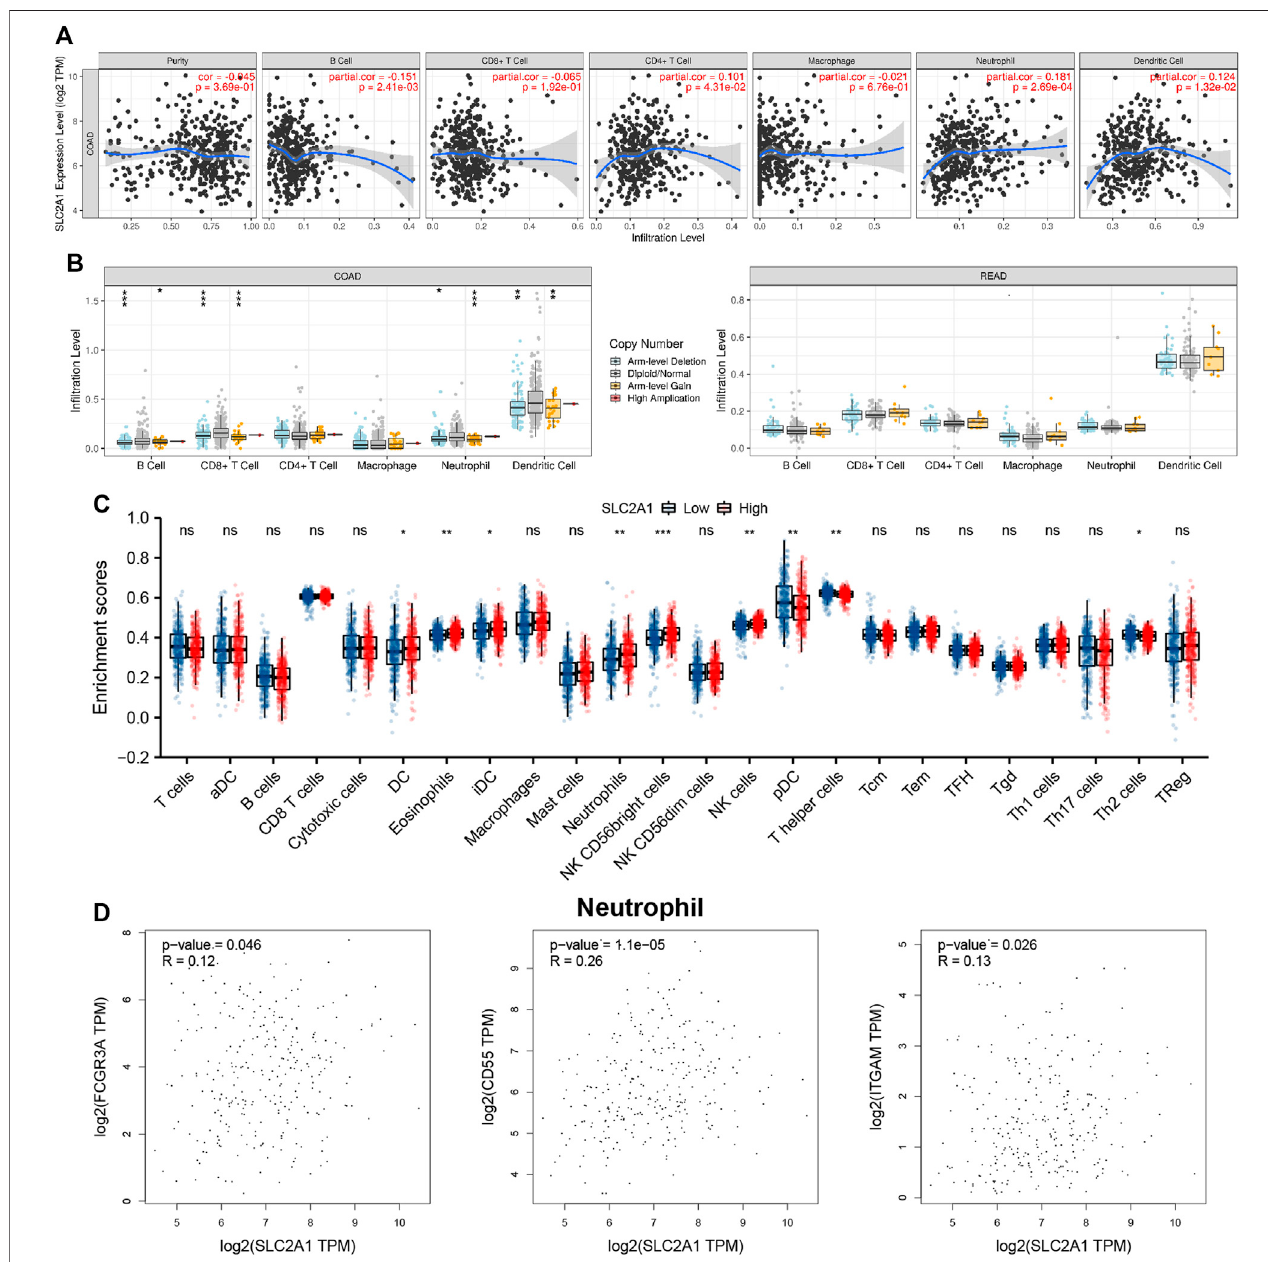
FIGURE6| AssociationsbetweenSLC2A1andTumorImmuneIn fi ltratingCells. (A) AssociationbetweentheexpressionlevelofSLC2A1andimmuno fi ltrationcells in colorectal cancer (CRC). (B) SLC2A1 CNV affects the in fi ltrating levels of B cell, CD4+ T cell, macrophages, neutrophils, and dendritic cell in CRC. (C) Changes of 24 immunecellsubtypesbetweenhighandlowSLC2A1expressiongroupsinCRCtumorsamples. (D) SLC2A1expressioncorrelatedwithneutrophilsinCRC.*, p < 0.05; **, p < 0.01; ***, p < 0.001; ****, p < 0.0001; ns, no signi fi cant.